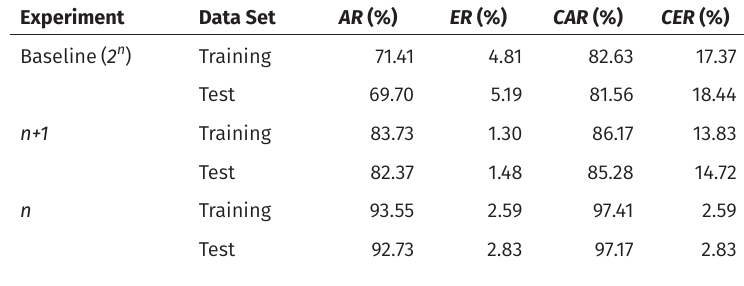
Table 7: Accuracy and Error rates for the Training and Test data